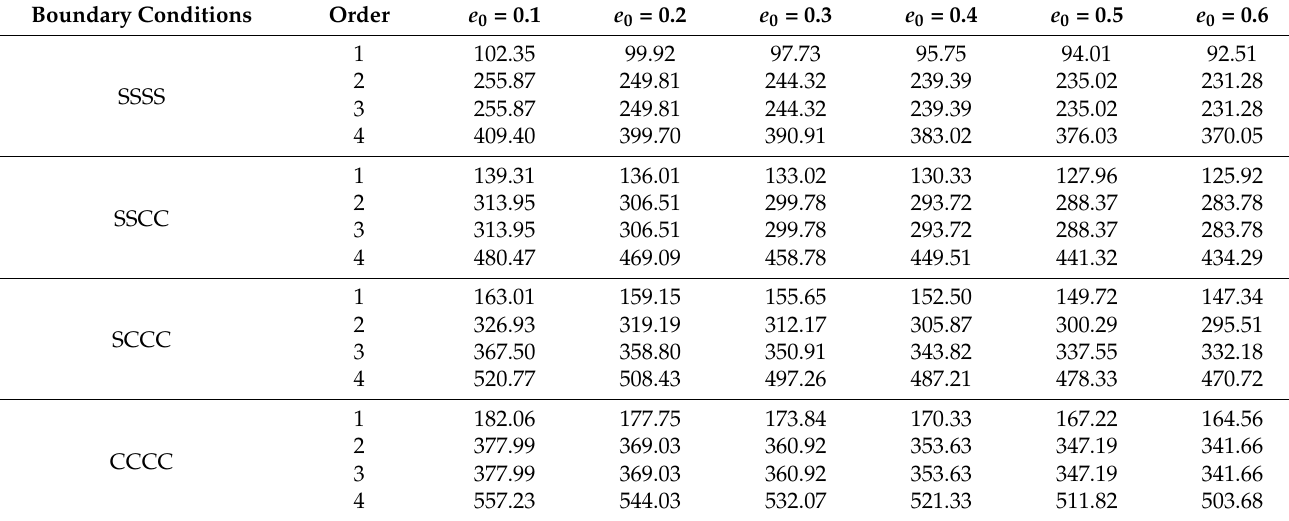
Table A1. Free vibration frequency ω (rad/s) of GPL reinforced porous composite plate with different porosity coefficients. Boundary Conditions